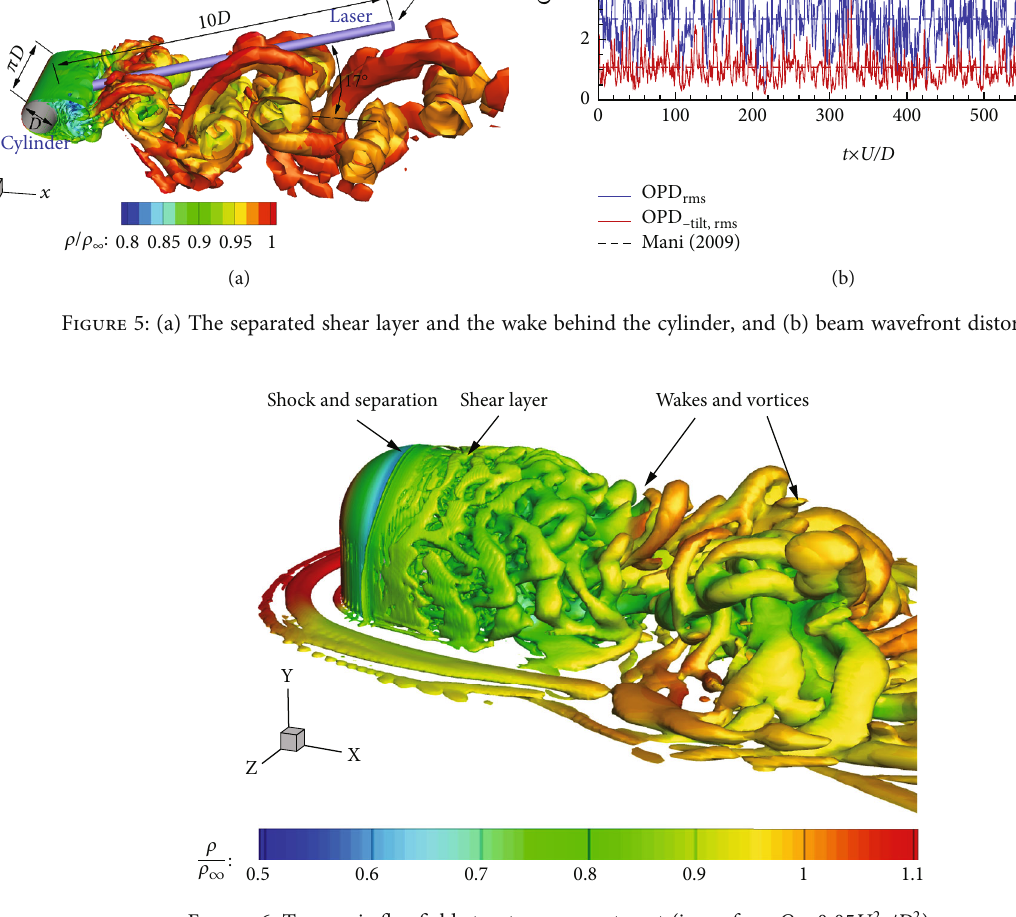
Figure 6: Transonic fl ow fi eld structure over a turret (isosurface: Q = 0 : 05 U 2